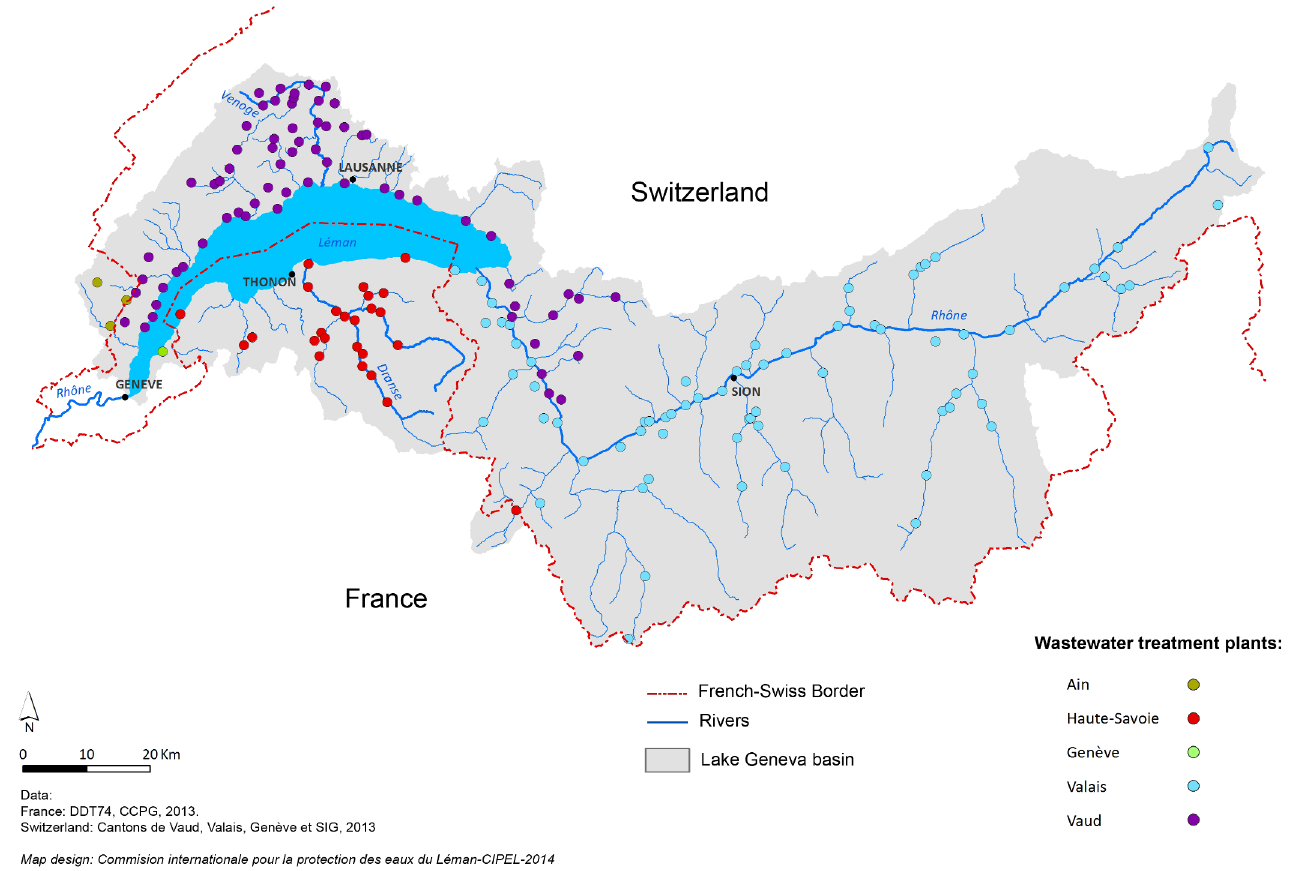
Fig 1. Map of the study area and sampling site (Thônon-les-Bains). Effluent from wastewater treatment plants discharged into the Lake Geneva catchment area (CIPEL: Commission Internationale pour la Protection des Eaux du